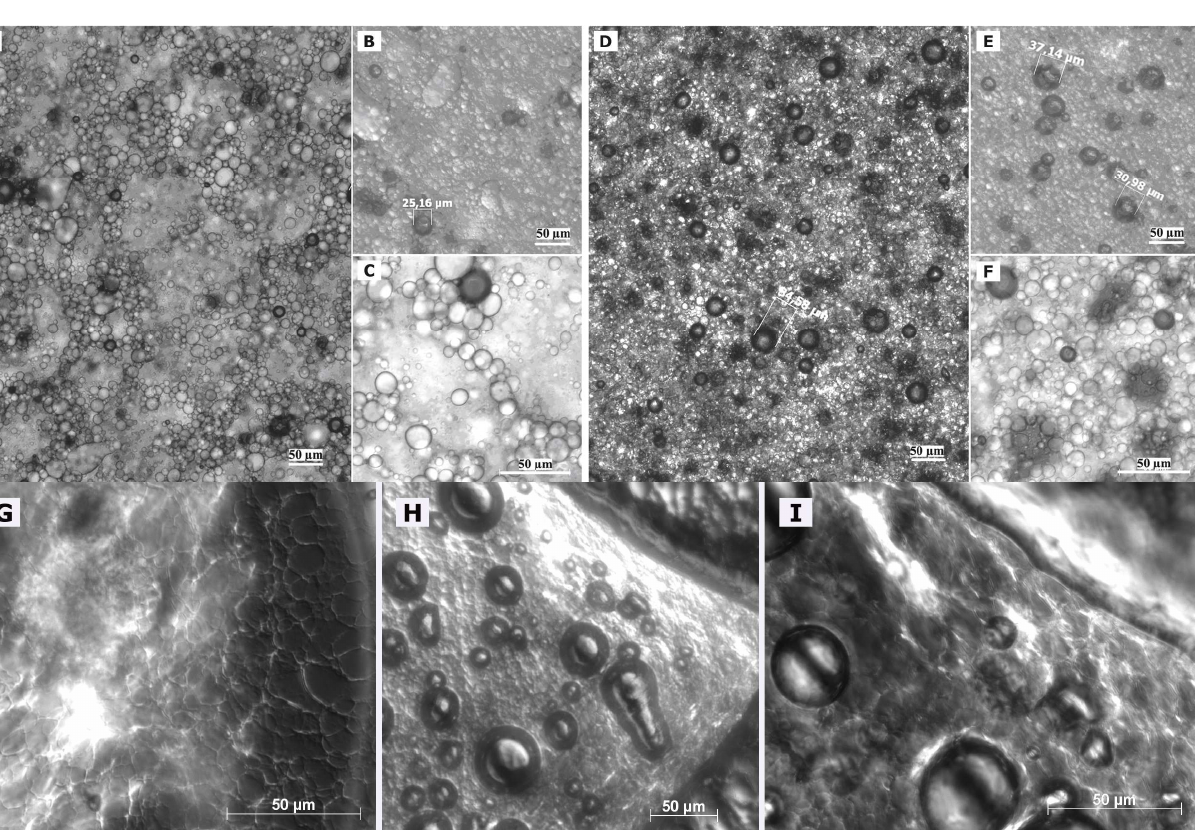
Figure 3. Images of fresh as well as stored macroemulsions as observed by optical light microscopy. Images 3A, 3B and 3C show a blank macroemulsion directly after preparation while the corresponding images 3D, 3E and 3F show the same formulation after 6 months of storage. The employed microscopic modes were 10x magnification/bright field (3A, 3D), 20x magnification/DIC (3B, 3E and 3G, 3H, 3I) and 40x magnification/bright field (3C, 3F). The indicated scale bars represent 50 µm. Images 3G, 3H and 3I represent artefacts of fresh macroemulsions obtained after 20 minutes of storage of the object